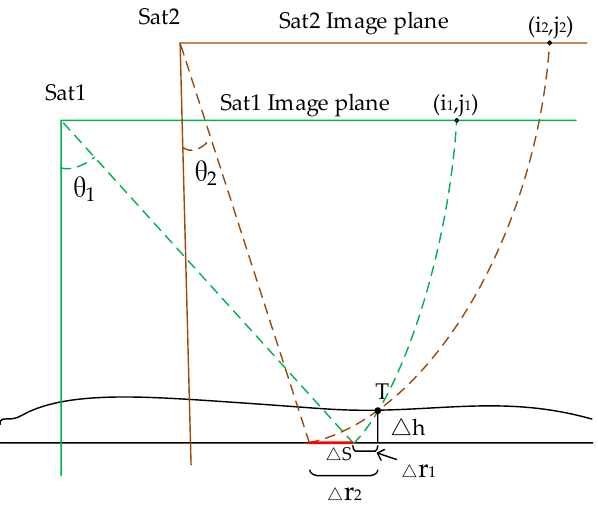
Figure 3. Schematic diagram showing the intersection of conjugate points ( i 1 ,j 1 ) and ( i 2 ,j 2 ). Δ h : elevation error of T; △ r 1 and △ r 2 : positioning errors caused by elevation error; Δ S : deviation of ground plane; Sat 1 and Sat2: satellites; T: ground point; 1 and 2 : incidence angles. Assuming that the geolocation parameters of Sat1 and Sat2 (including measuring track, slant range, and Doppler parameters) are accurate and the elevation of T is correct according to the geometric positioning model, the conjugate points ( i 1 ,j 1 ) and ( i 2 ,j 2 ) should be positioned at the same location T by an indirect localization algorithm of the range-Doppler location model. However, it is often difficult to locate ( i 1 ,j 1 ) and ( i 2 ,j 2 ) at the same point on the ground when utilizing satellite data. This is caused by the geolocation error and stereoscopy errors induced by the elevation error of the ground object T.